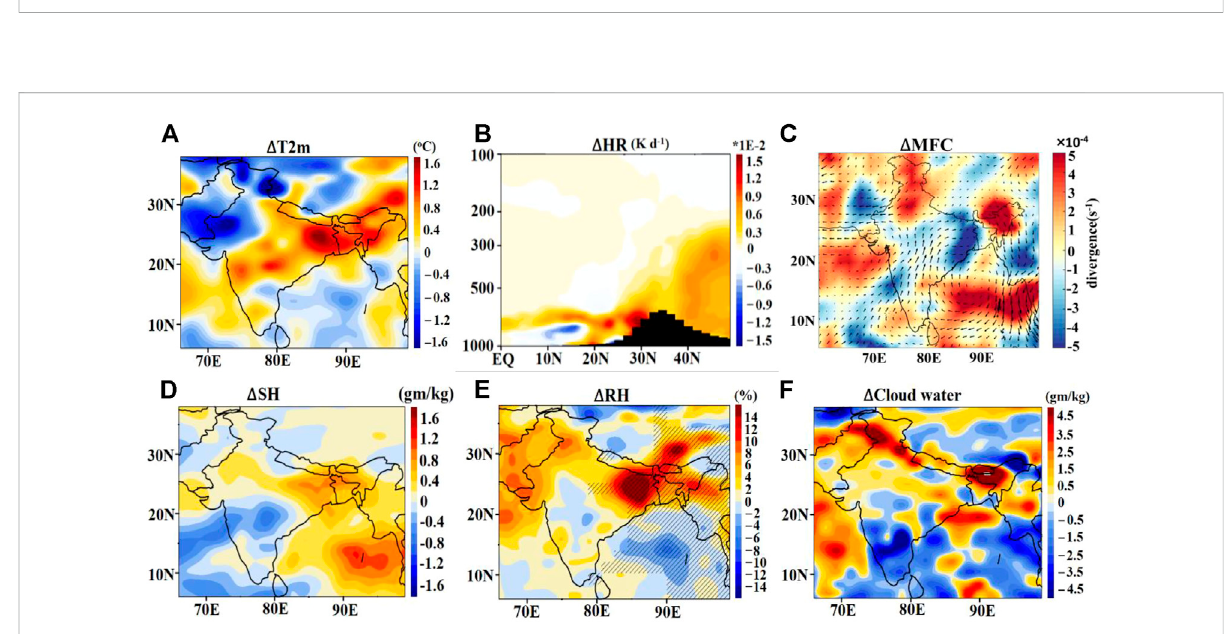
FIGURE 4 SpatialdistributionofECHAM6-HAMMOZsimulatedanomalies(C19 — CTRL)averagedover10membersandforlockdownperiodfor (A) 2 mair temperature ( Δ T2m, o C) (B) heating rate (averaged over 70 – 90 ° E, Δ HR, K d − 1 ) (C) column integrated moisture fl ux divergence (1,000 – 300 hPa), arrows indicate column integrated moisture fl ux (kg m − 1 s − 1 ), (D) speci fi c humidity (averaged for 1,000 – 500 hPa, gm kg − 1 ), (E) relative humidity (averaged for 1,000 – 500 hPa, %) and (F) cloud water (averaged over the surface to 500 hPa,